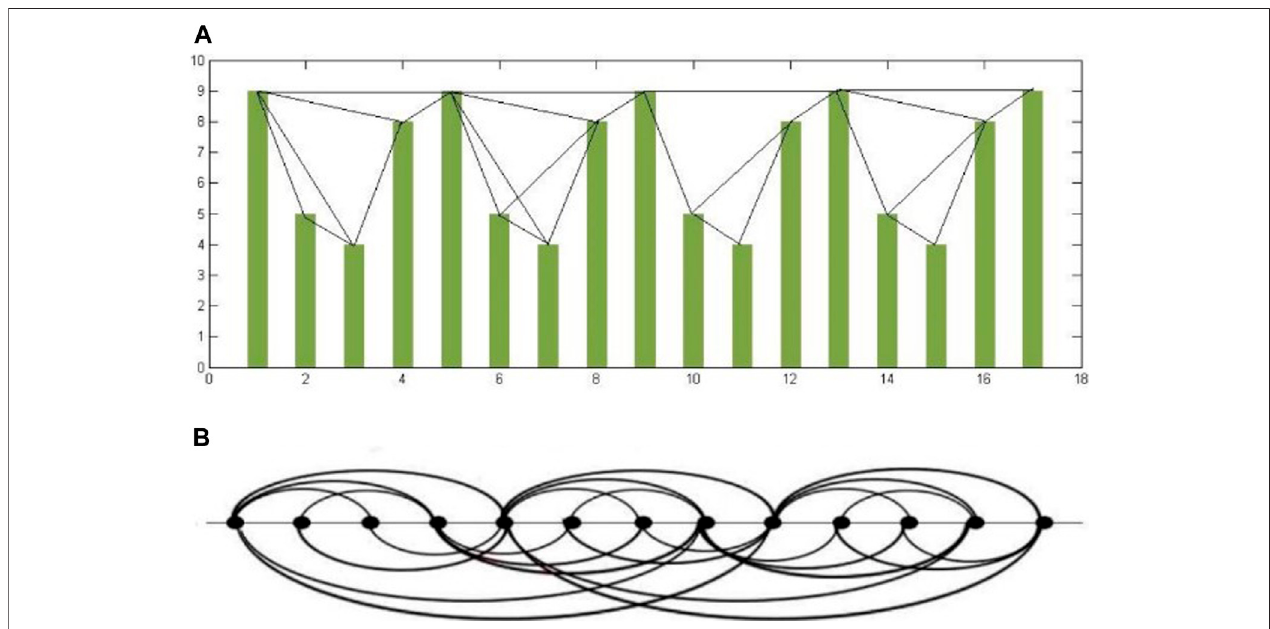
FIGURE 1 | Visibility graph